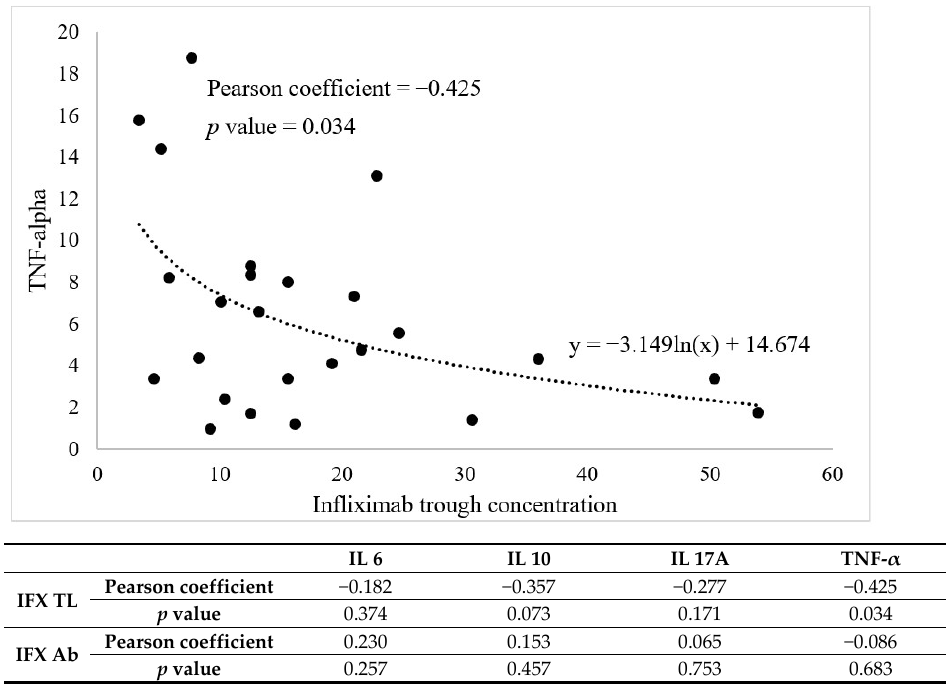
Figure 3. Pearson correlation analysis was used to assess the relationship between each cytokine and infliximab trough concentration, as well as anti-IFX antibody concentration, prior to the fourth dose administration.